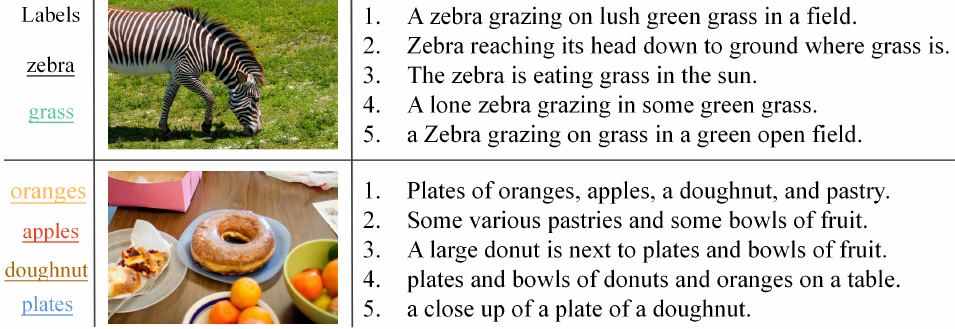
Figure 3. An example of an image from the MS COCO dataset and the captions associated with it. The first column shows the common labels for the images and text, with each image containing five corresponding